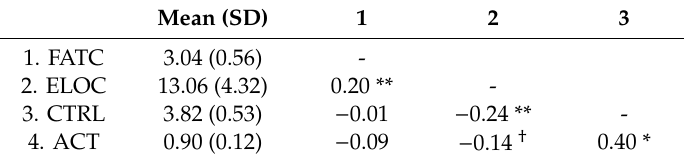
Table 3. Descriptive Statistics and Bivariate Correlations among the Measures in Study